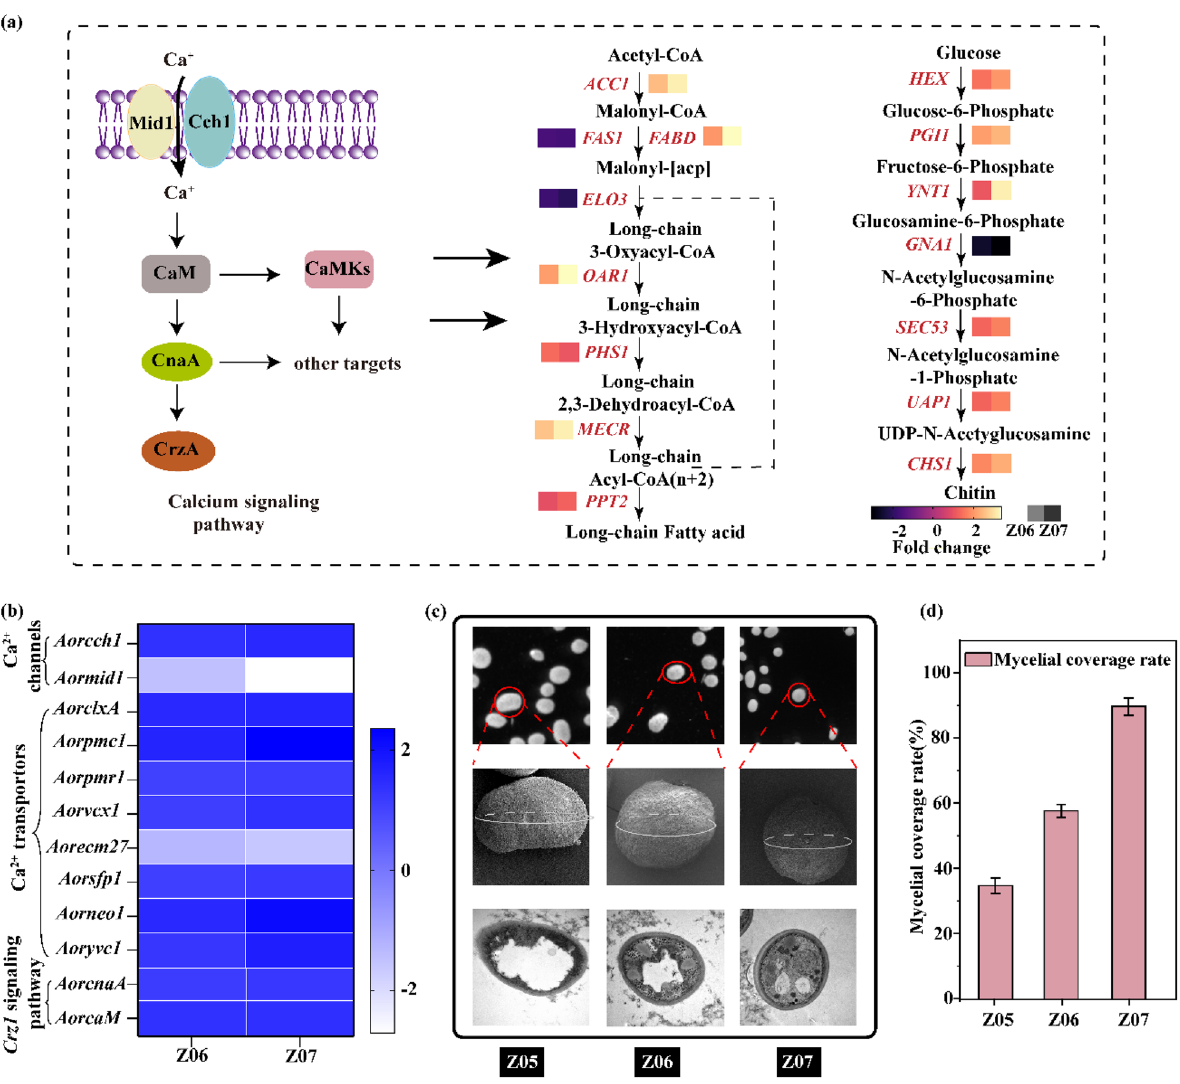
Fig. 6 Transcriptome analysis and morphological characterization to clarify the mechanism of mycelial pellets formation in Aspergillus oryzae . a Diagram of the mechanism of mycelial pellets. b Heat map of the mycelial pellets formation mechanism following comparison between strain Z06 and Z07. c The morphological characteristics of mycelial pellets of the strain Z05, Z06 and Z07 under scanning electron microscope. d Mycelial coverage rate of strain Z05, Z06 and Z07. All data are presented as mean values from three independent experiments. Error bars indicate the standard